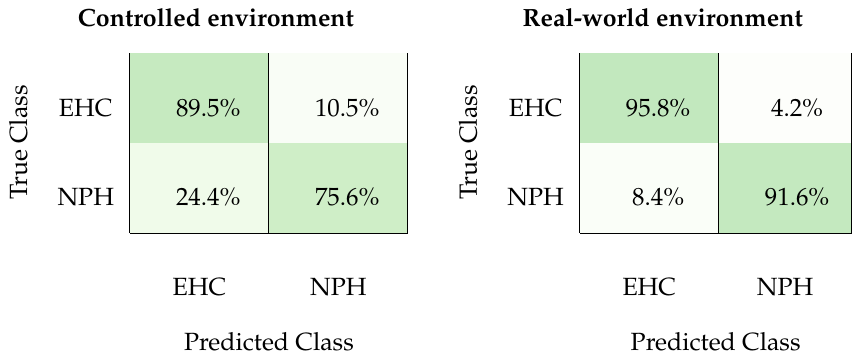
Table 3. Logistic regression classifier prediction in the controlled environment (left) and in the real-world environment (right) for the elderly healthy control group (EHC) and normal pressure hydrocephalus patients group (NPH). Green represents values closer to 100%, and white indicates values closer to 0%.